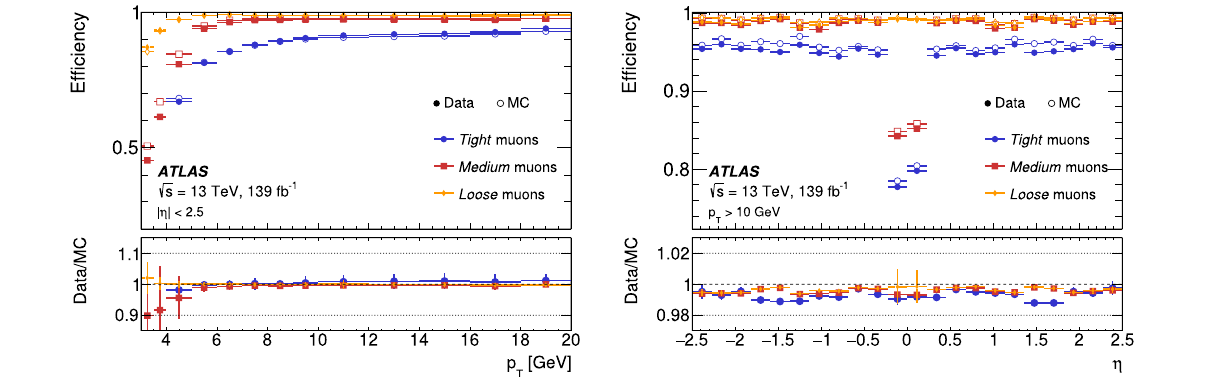
Fig. 12 Muon reconstruction and identification efficiencies for thepc Loose , Medium , and Tight criteria. The left plot shows the efficien- cies measured in J /ψ → μμ events as function of p T . The right plot displays the efficiencies measured in Z → μμ events as a func- tion of η , for muons with p T > 10 GeV. The predicted efficiencies are depicted as open markers, while filled markers illustrate the result